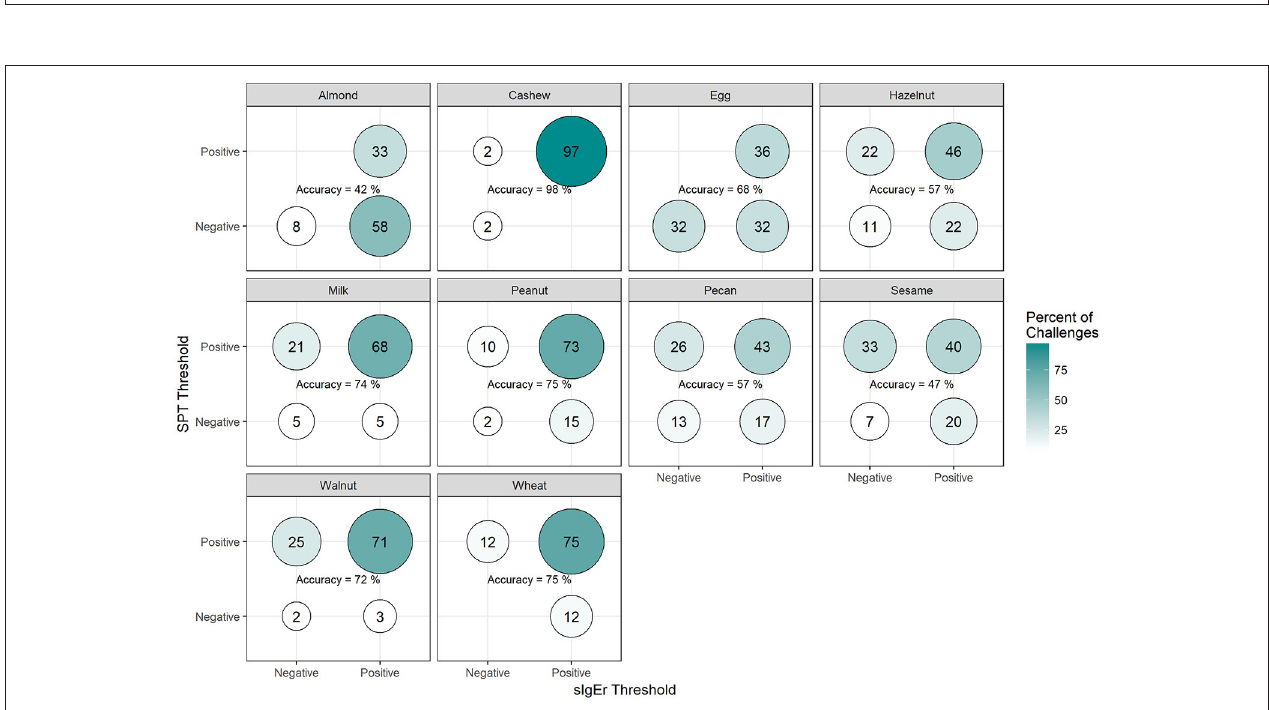
FIGURE 8 | Concordance of skin prick test (SPT) and allergen-specific IgE to Total IgE ratio (sIgEr) CTD-dependent thresholds in positive challenges. Among participants with positive challenges, the percentage of participants with each combination of SPT and sIgEr values above or below the CTD-dependent ROC thresholds by food. Percentages in each food add up to 100%. Accuracy is the percentage of SPT positive and sIgEr positive plus the percentage of SPT negative and sIgEr negative.